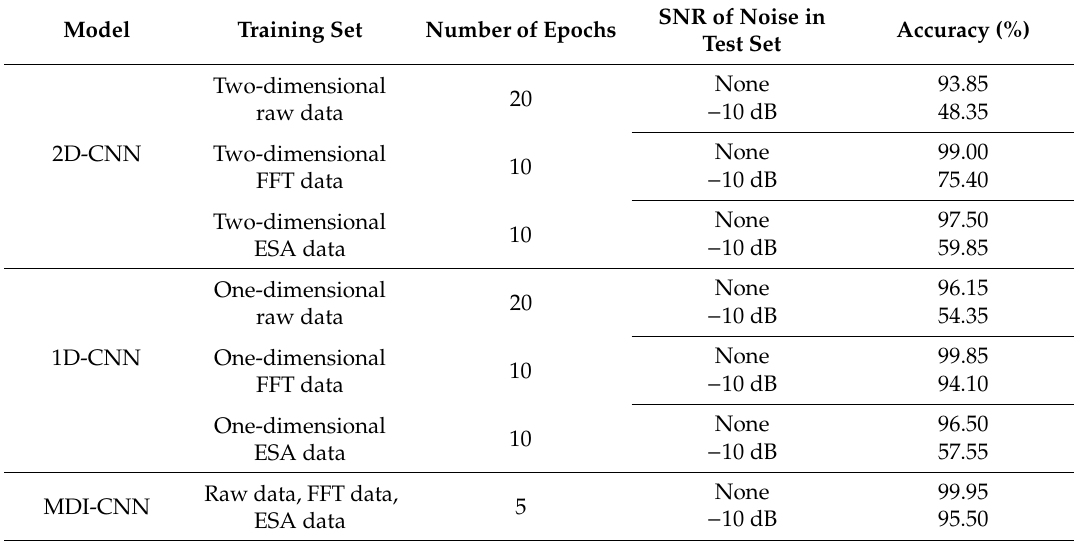
Table 5. Diagnosis results of di ff erent